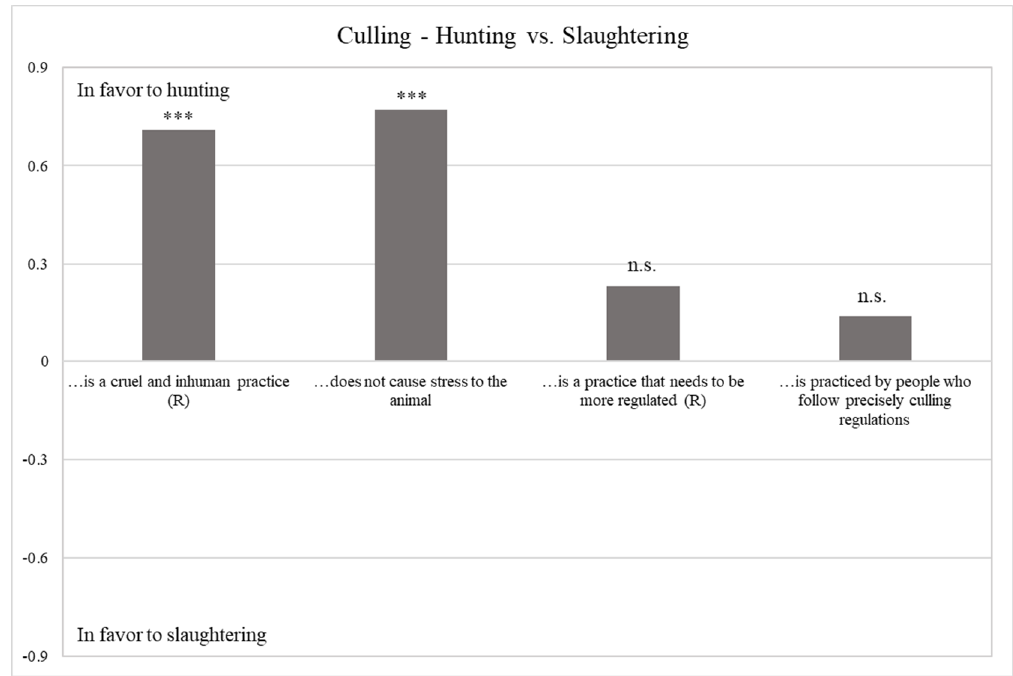
Figure 2. Difference between perceptions towards hunting vs. slaughtering. *** Sign. < 0.001; ** Sign. < 0.010; * Sign. < 0.050; n.s. not significant .